Question: Which kind of chart has been used to present this data?
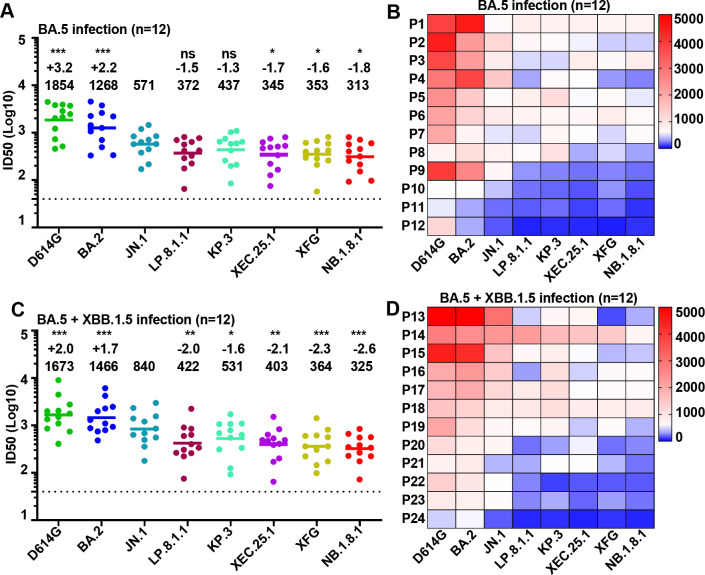
Answer: heatmap